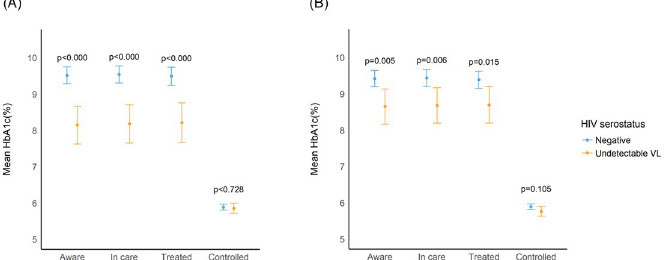
Fig 2. Mean glycated hemoglobin (HbA1c) among adults with hypertension in uMkhanyakude, KwaZulu-Natal, South Africa, according to HIV/ART status. A. Minimally adjusted predicted mean HbA1c. � Estimates adjusted for age and sex only and include inverse probability of sampling weights. B. Fully adjusted predicted mean HbA1c. � Estimates adjusted for age, sex, BMI, wealth tertile, education, and smoking status, and include inverse probability of sampling